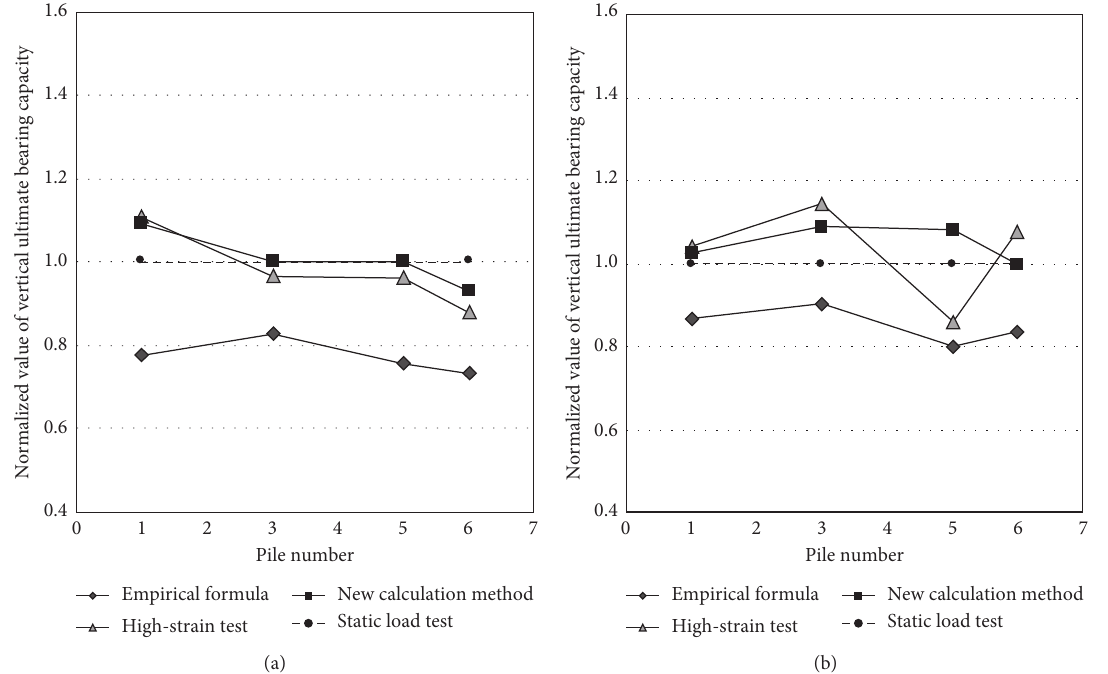
Figure 15: Comparison the results between different calculation methods and SLTs (normalized values) at (a) the soft rock bearing stratum site and at (b) the hard rock bearing stratum